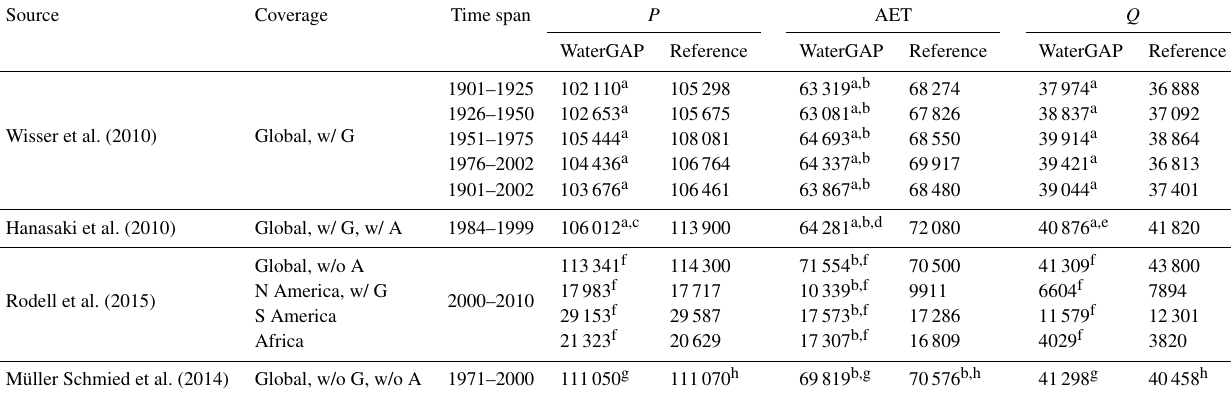
Table 6. Global and continental estimates of WaterGAP water balance components compared to literature values (km 3 yr − 1 ). WaterGAP results are analyzed for the same time span and spatial coverage as the reference and are comparable in terms of precipitation undercatch (see